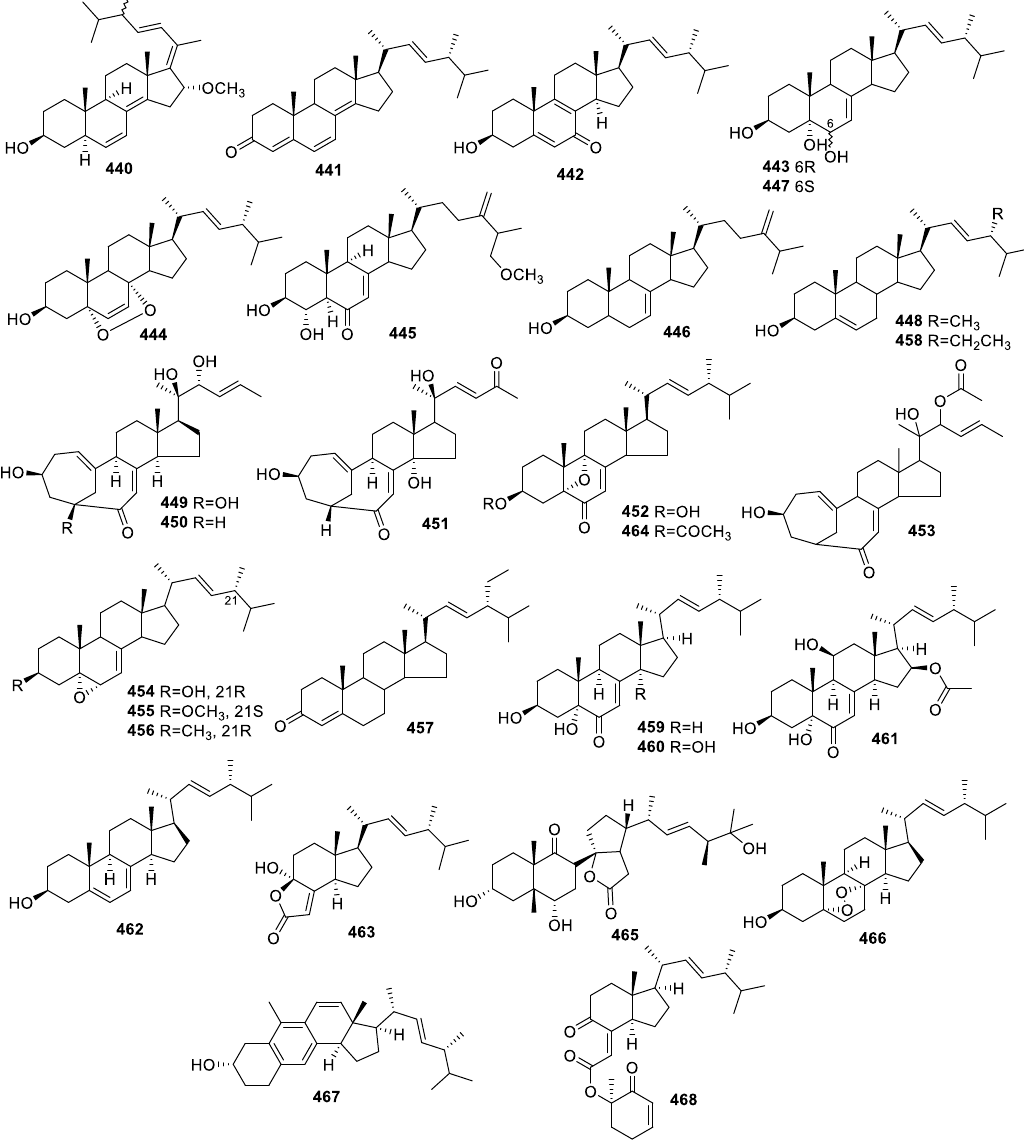
Figure 18. Chemical structures of steroids ( 440 – 468 ).